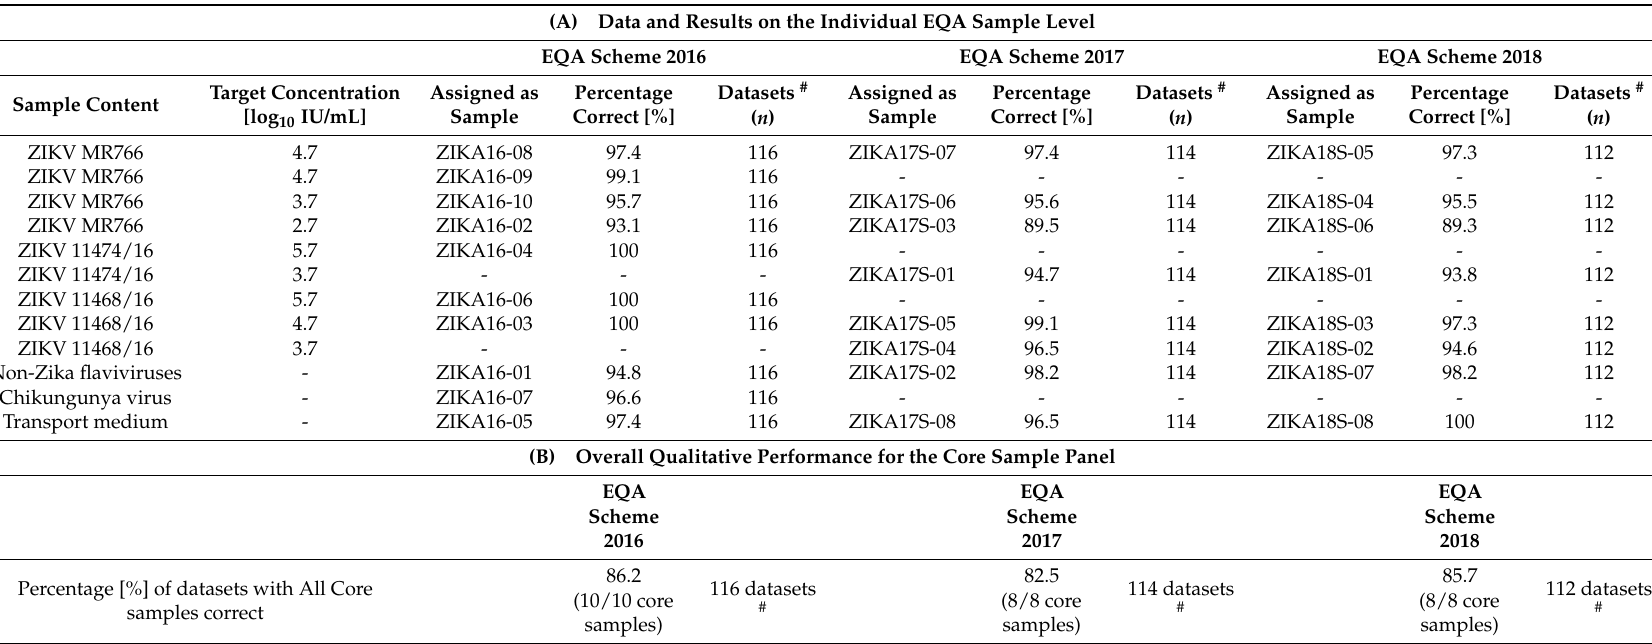
Table 1. Quality Control for Molecular Diagnostics (QCMD) Zika Virus External Quality Assessment (EQA) Programme. Panel compositions and performances,